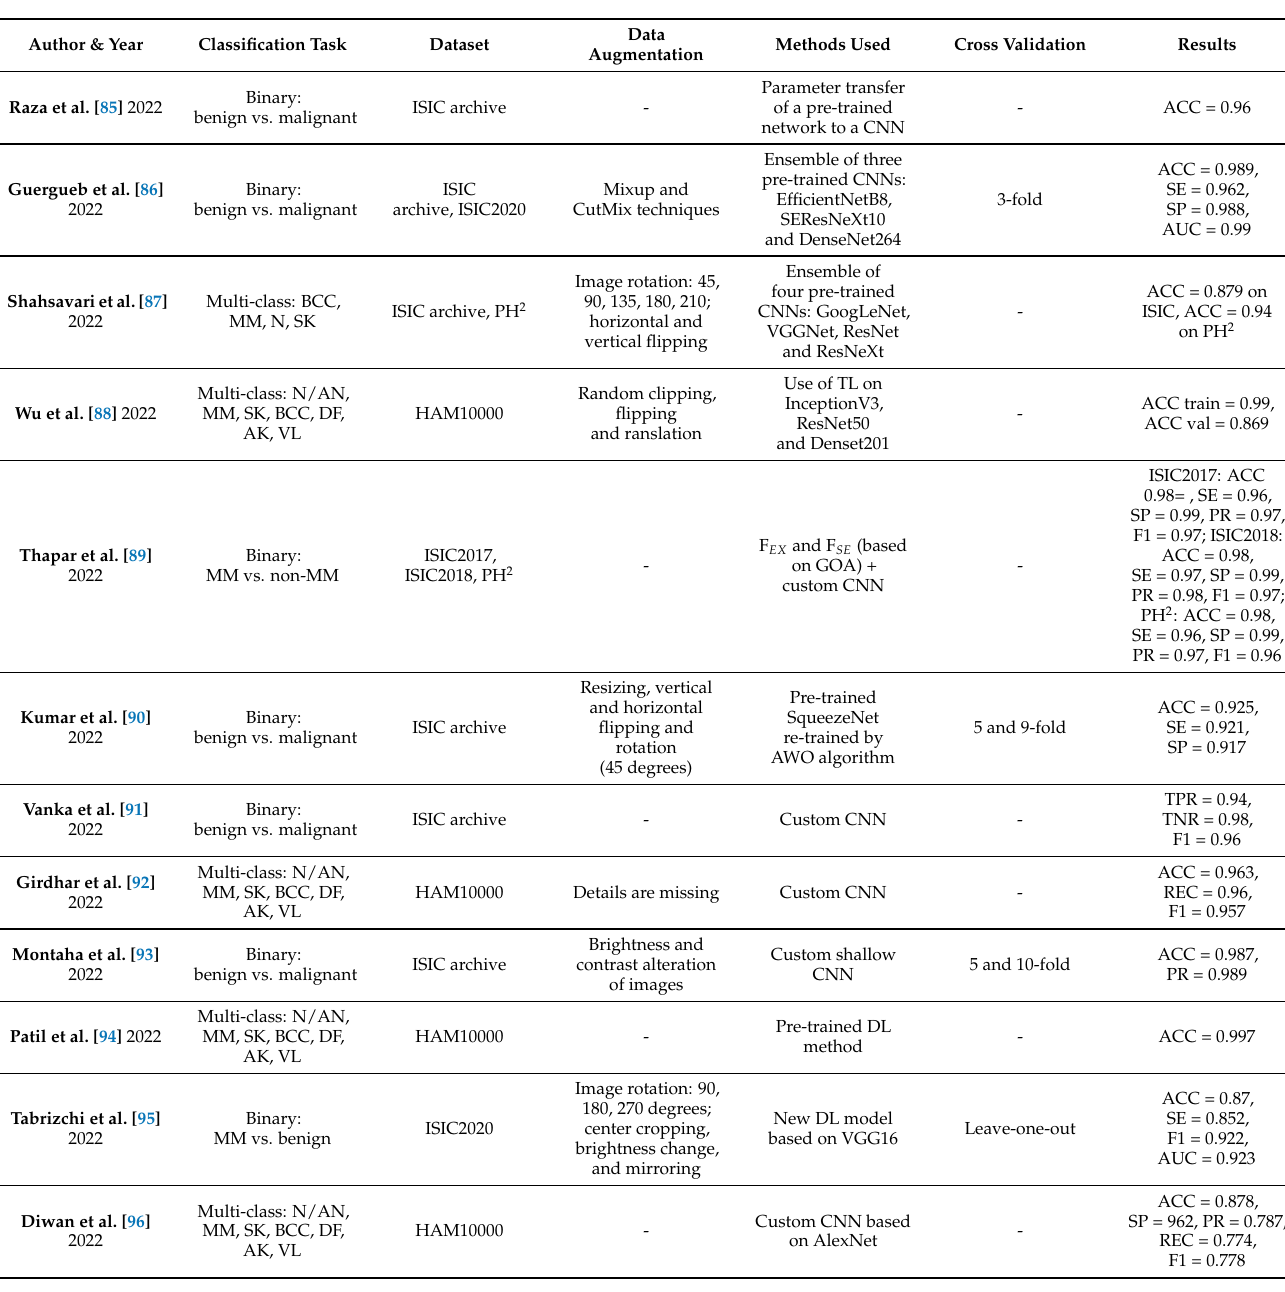
Table 5. Overview of cited works using DL approaches (results have been rounded). F EX and F SE abbreviations are used for feature extraction and selection, respectively. The symbol “-” indicates that no information is provided on a particular